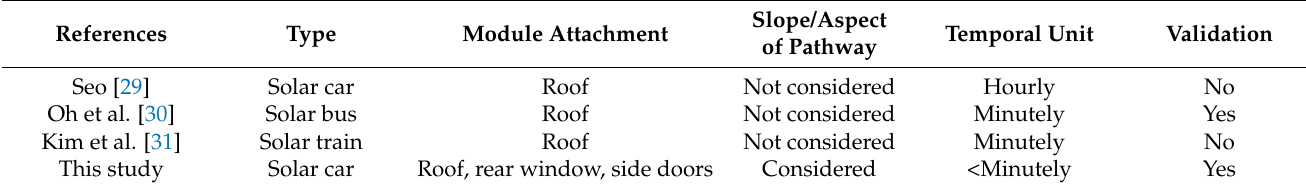
Table 1. Summary of previous studies on the PV potential assessment of solar